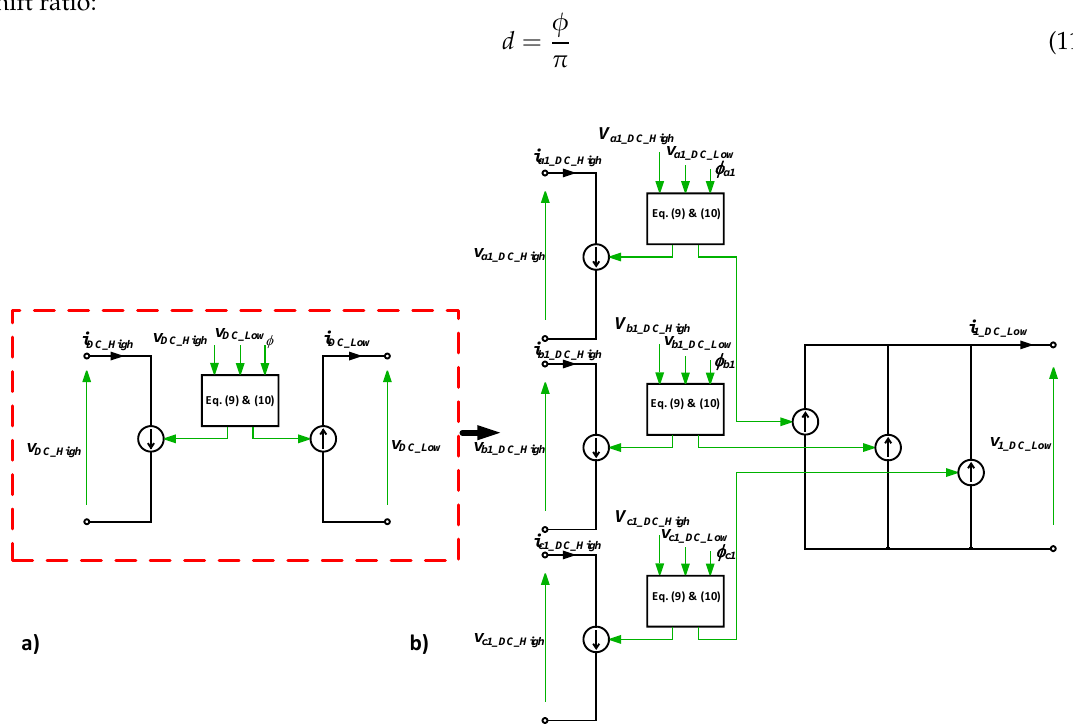
Figure 5. The proposed average model of the MAB, ( a ) average model of the single DAB, ( b ) average model of the full three-phase MAB.